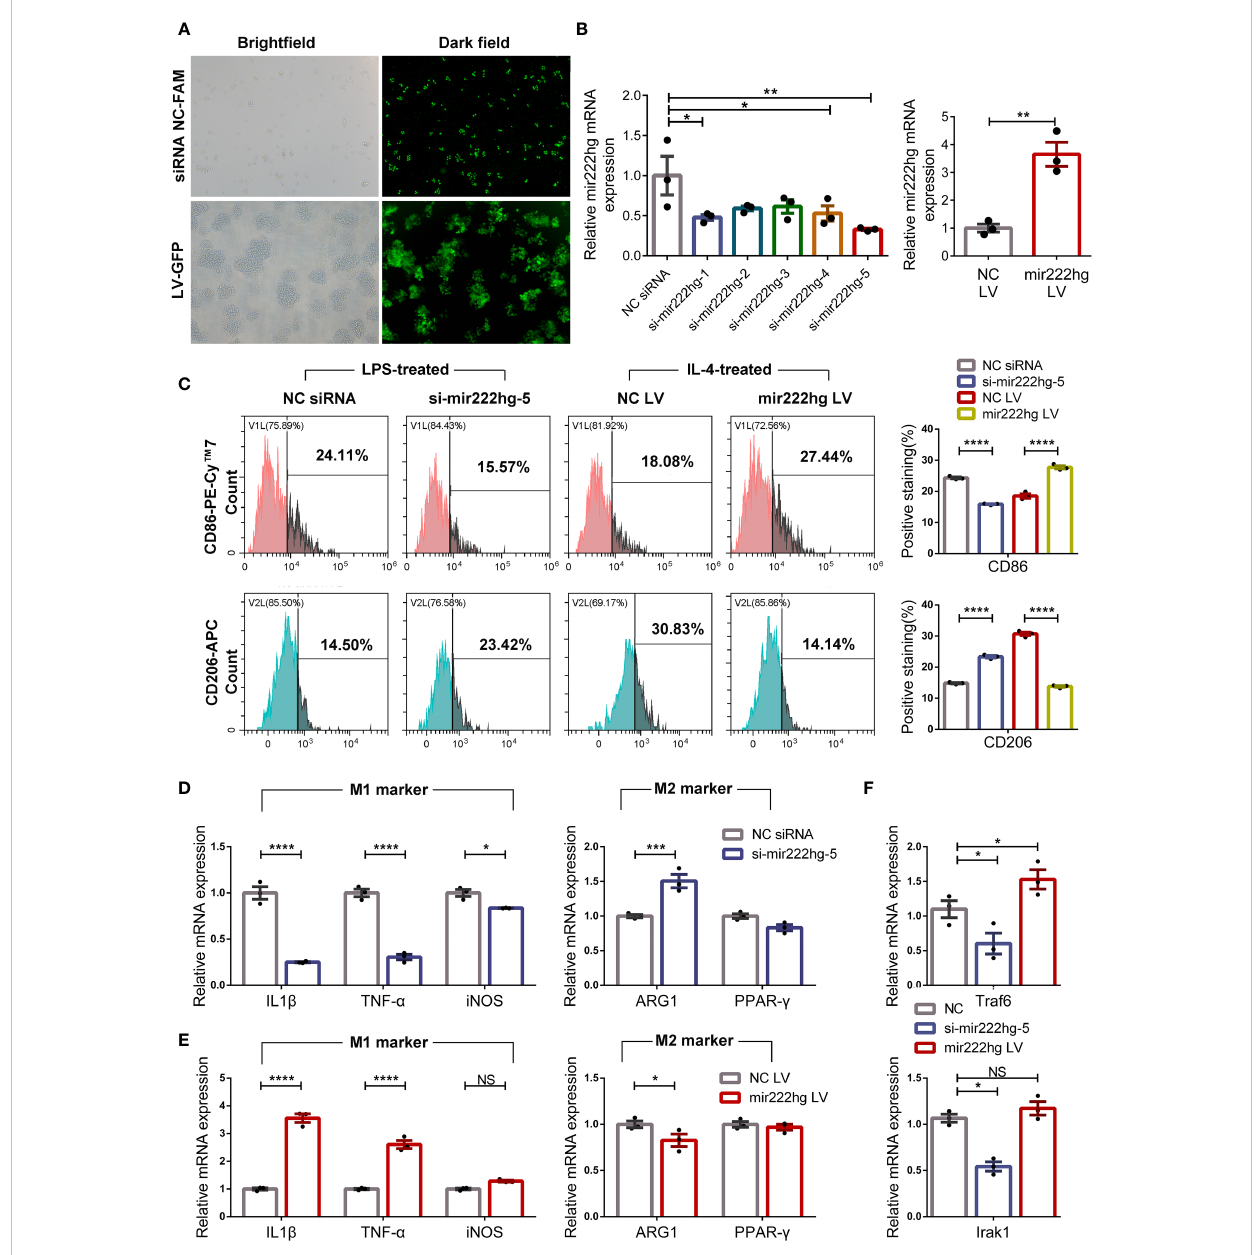
FIGURE 5 Overexpression or knockdown of mir222hg correlated with macrophage polarization RAW264.7 cells were transfected with si-mir222hg-1-5, NC siRNA, mir222hg LV, or NC LV. Cells transfected with si-mir222hg-5 and NC siRNA were treated with 100 ng/ml LPS for 24 h, whereas those transfected with mir222hg LV and NC LV were treated with 40 ng/ml IL-4 for 48 h. (A, B) Immuno fl uorescence analysis (A) and qRT-PCR (B) assays were performed to verify the transfection ef fi ciency of the siRNA and overexpressing lentivirus. (C) Representative fl ow cytometry histograms (left) and statistical analysis (right) showing the surface expression of CD86 and CD206. (D-F) qRT-PCR showing IL-1 b , TNF- a , iNOS, ARG1, PPAR- g , Traf6, and Irak1 relative mRNA expression. Each point represents data from one individual sample. Data are shown as the mean ± SEMs (n= 3 per group). Data are merged from three independent experiments. Statistical signi fi cance was assessed by unpaired t-test for experiments comparing two groups, whereas two-way ANOVA followed by Sidak ’ s multiple comparisons test was used for comparisons between more than two groups. * p< 0.05, ** p< 0.01, *** p< 0.001, **** p< 0.0001, NS no signi fi